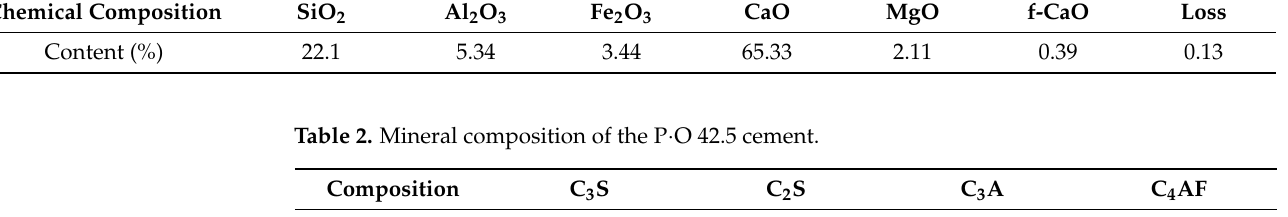
Table 1. Chemical composition of the P · O 42.5 cement.